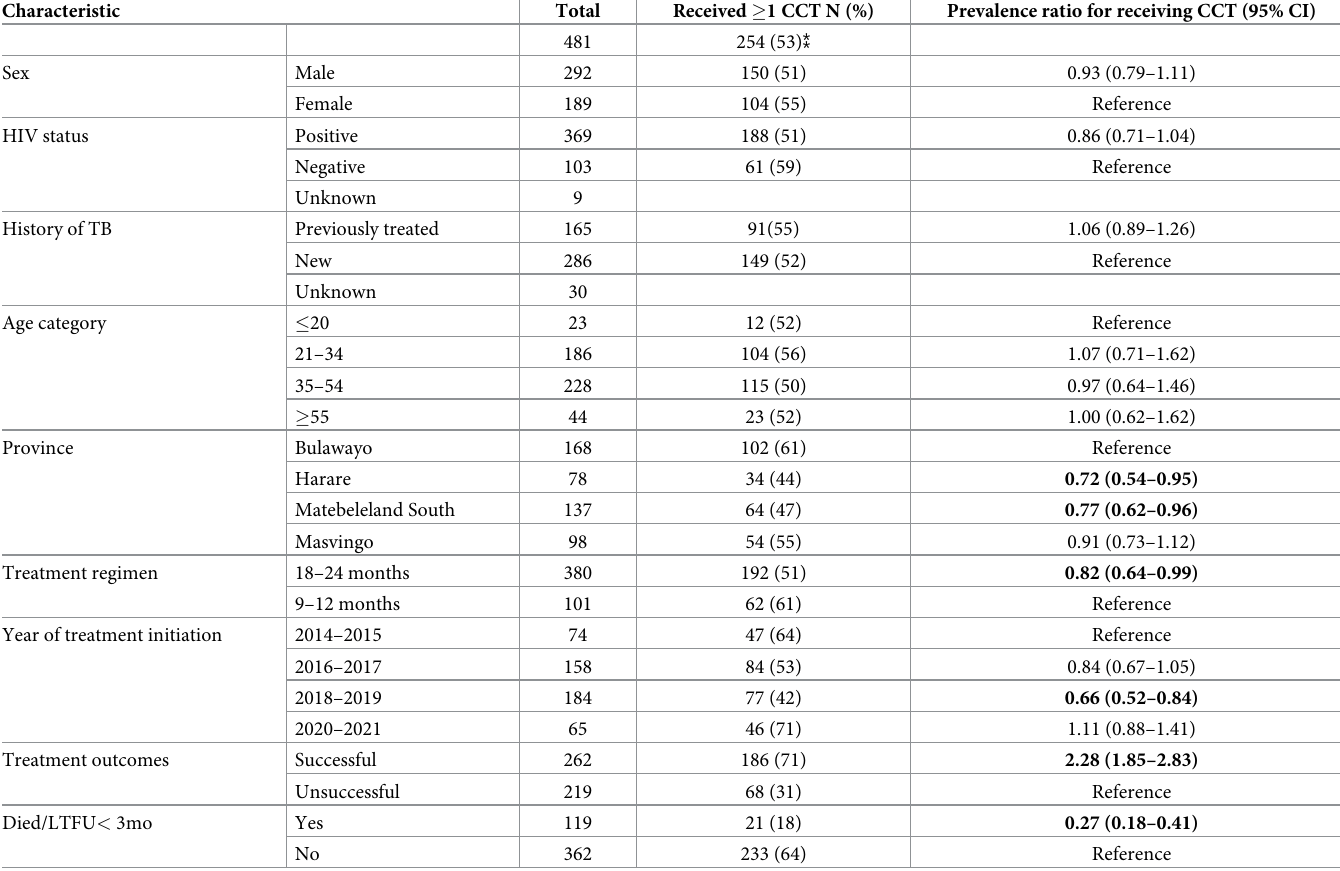
CCT = Conditional cash transfer; CI = Confidence interval; LTFU = Loss to follow up; ⁑ = Row